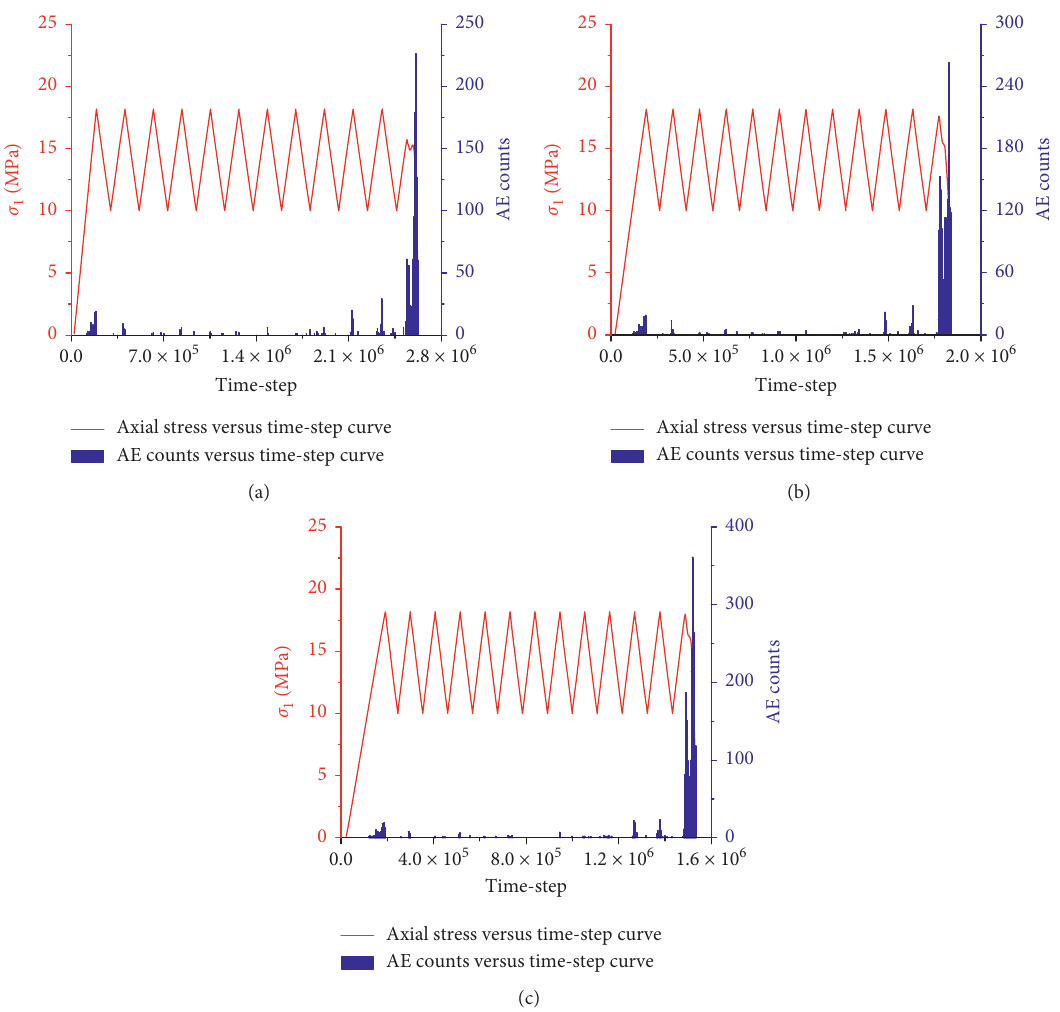
Figure 9: AE counts and axial stress versus time-step curves under different loading-unloading rates: (a) 0.02m/s, (b) 0.03m/s, and (c) 0.04m/s.